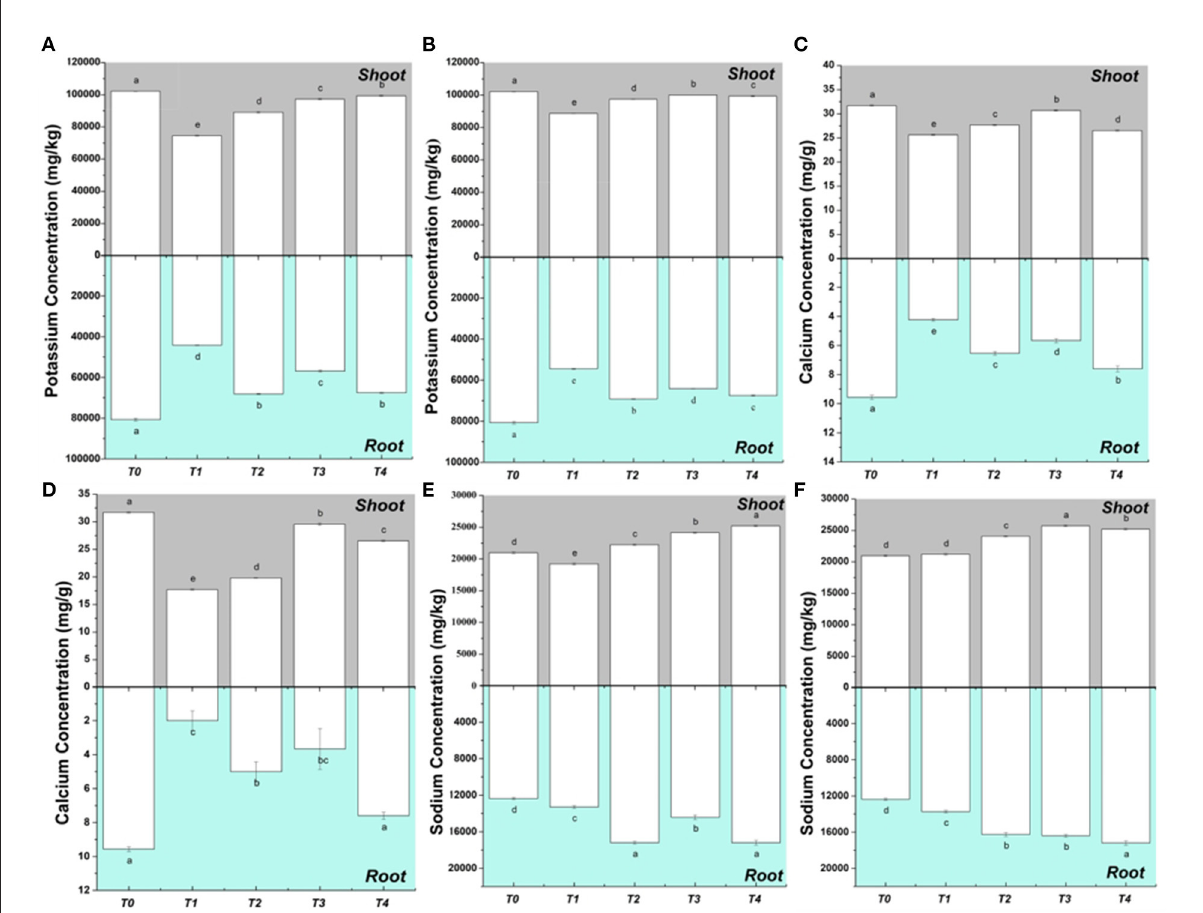
FIGURE3 Mineral ions (K, Ca, and Na) contents in P. hysterophorus under the effect of various treatments in two sets. (A) K concentration in P. hysterophorus in set-1, (B) K concentration in P. hysterophorus in set-2, (C) Ca concentration in P. hysterophorus in set-1, (D) Ca concentration in P. hysterophorus in set-2, (E) Na concentration in P. hysterophorus in set-1, and (F) Na concentration in P. hysterophorus in set-2.